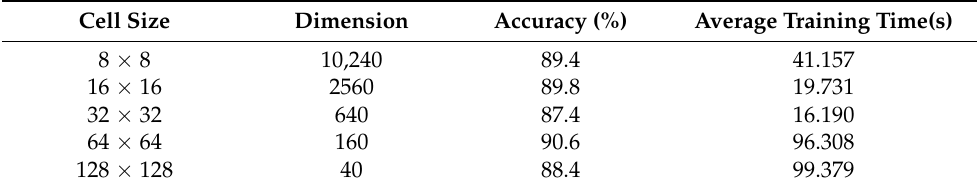
Table 3. Experimental results of RotLBP feature with different cell sizes.